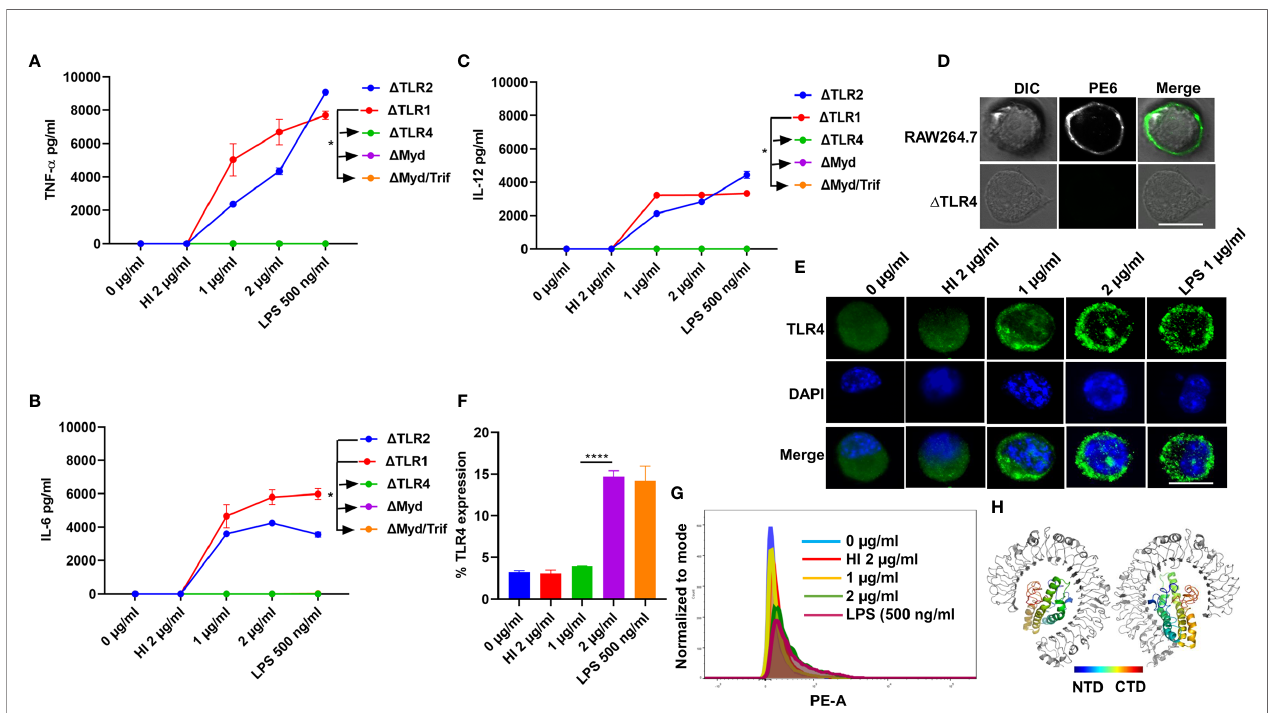
FIGURE 2 | PE6 interacts with surface immune receptor TLR4 and induces its increased expression and secretion of proin fl ammatory cytokines. (A – C) Mouse macrophage knockout cells D TLR1, D TLR2, D TLR4, D Myd88, and D Myd88/Trif, were stimulated with PE6 (1 and 2 m g/ml), LPS 500 ng/ml and HI PE6 (2 m g/ml) treated with proteinase K (PK; 50 mg/ml), followed by heat inactivation at 100°C for 4 h. Approximately 24 h of post-treatment, cell culture supernatants were collected, and sandwich ELISA quanti fi ed TNF- a , IL-6, and IL-12 levels. (D) RAW264.7 and D TLR4 macrophage cells were treated with puri fi ed recombinant PE6 (2 µg/ml). Approximately 2 h of post-treatment, cells were fi xed using 4% formaldehyde to stabilize the interaction of PE6 to the cell surface localized receptor. Fixed cells were washed and probed with polyclonal anti-PE6 antibody (1:500) dilution for 2 h. Post-primary antibody treatment, cells were washed three times with cold PBS and probed with anti-rabbit A488 conjugated secondary antibody. After three washing steps with cold PBS, cells were mounted on ProLong Anti Fade Glass mount and visualized using Carl Zeiss fl uorescence microscope. Scale bar indicates 10 µm. (E) Immuno fl uorescence microscopic images showing membrane organization and expression pattern of TLR4 in PE6 treated macrophage cells. Concentrations of PE6 used are marked in the fi gure. The anti-rabbit TLR4 monoclonal antibody was used to probe the localization of TLR4. A488 conjugated secondary antibody was used for signal detection. DAPI was used to stain the nucleus. Untreated and HI PE6 treated cells were used as negative controls. LPS treated cells were used as a positive control. Scale bars indicate 10 µm. (F) The quanti fi cation of TLR4 expression is shown as a bar graph. (G) FACS was used to study the expression of TLR4 on PMA differentiated and PE6 treated THP1 cells. Monoclonal anti-TLR4 antibody conjugated to PE fl uorophore was used in the FACS experiment. Data were analyzed by one-way ANOVA with Tukey ’ s multiple comparison post-test. Data are representative of three independent experiments. *P < 0.05 and ****P < 0.0001 vs . controls. (H) TLR4-PE6 model of the top-scoring structure obtained through ClusPro protein-protein docking. PE6 (Colored) protein fi ts into TLR4 (Gray) ligand-binding pocket. The colored bar indicates coloring from N-terminal to the C-terminal domain of